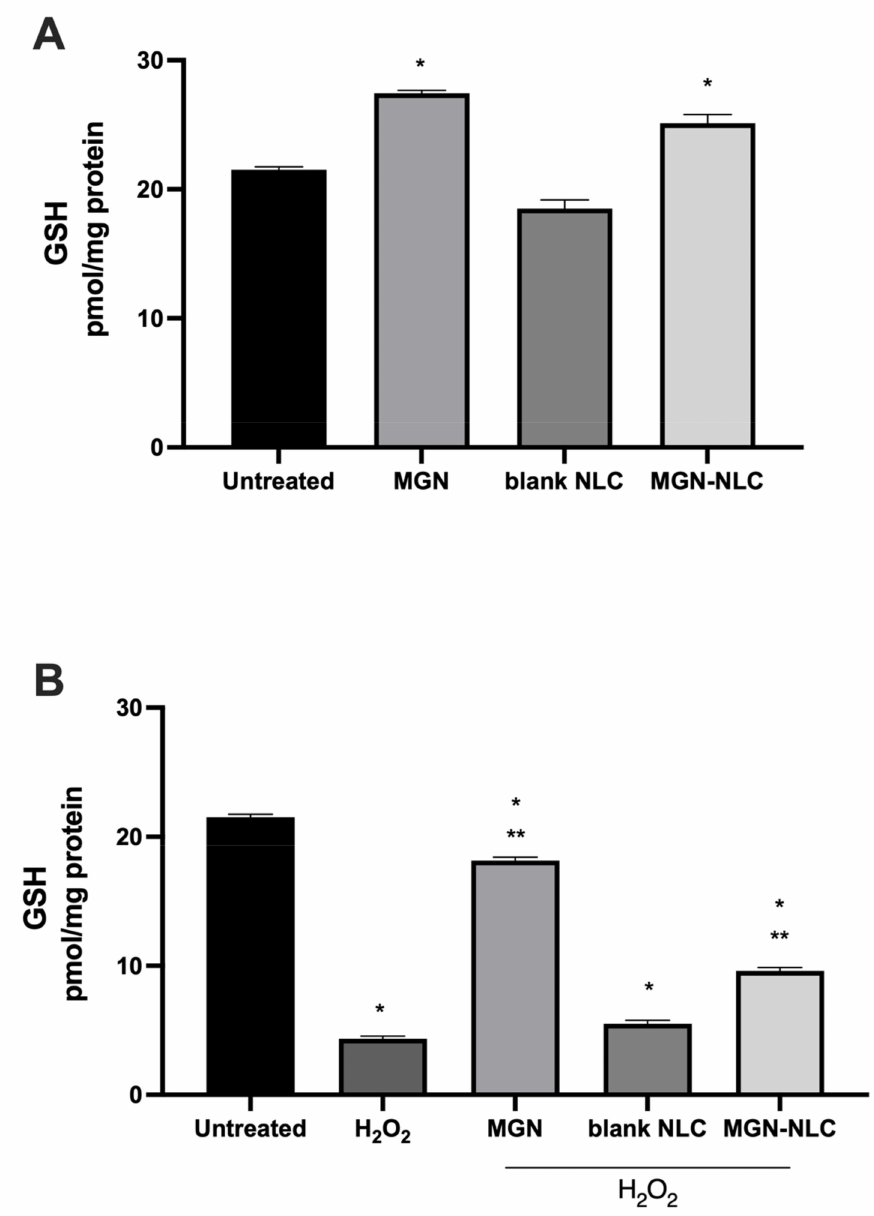
Figure 8. Intracellular content of reduced glutathione (GSH). ( A ) GSH level under normal conditions, ( B ) GSH level following 0.5 mM H 2 O 2 treatment for 30 min. * p < 0.05 versus untreated; ** p < 0.05 versus H 2 O 2